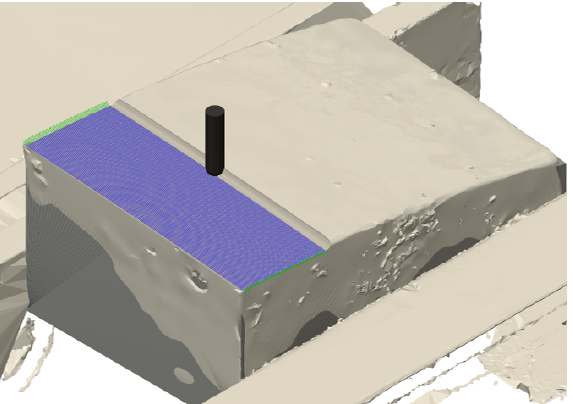
Figure 6. CAM simulation using the scan as the stock model [19].